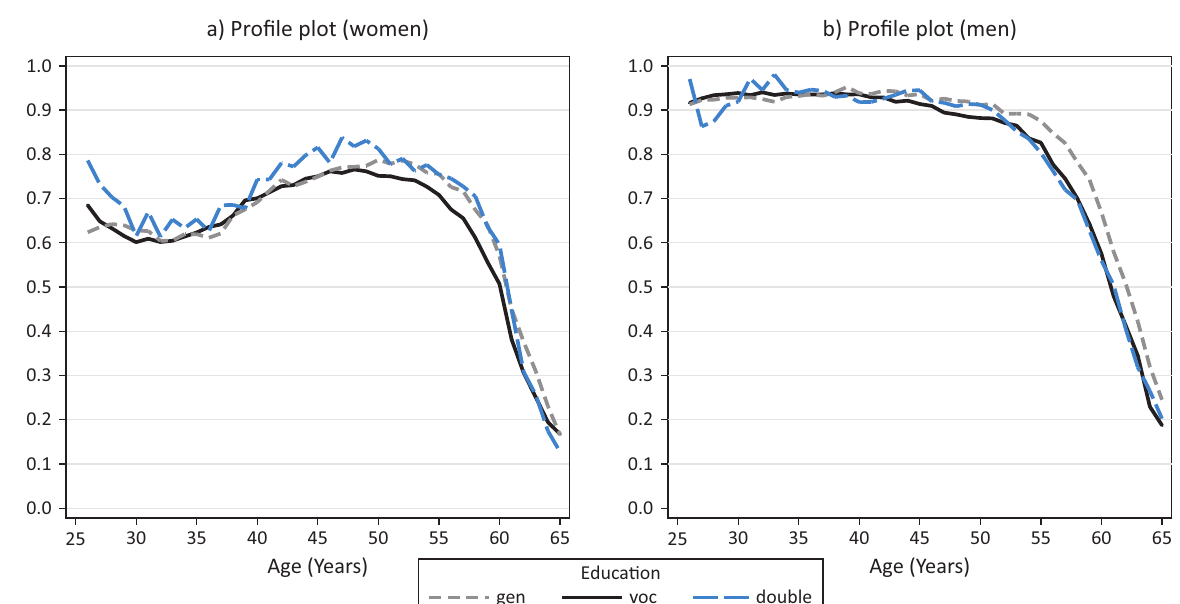
Figure A3. Sensitivity analysis: The role of double qualifications. Employment opportunity over the life course: General, vocational, and double qualifications by gender. Notes: Conditional profile plots for women (left) and conditional profile plots for men (right) estimated by gender-specific non-parametric state probability models on employment